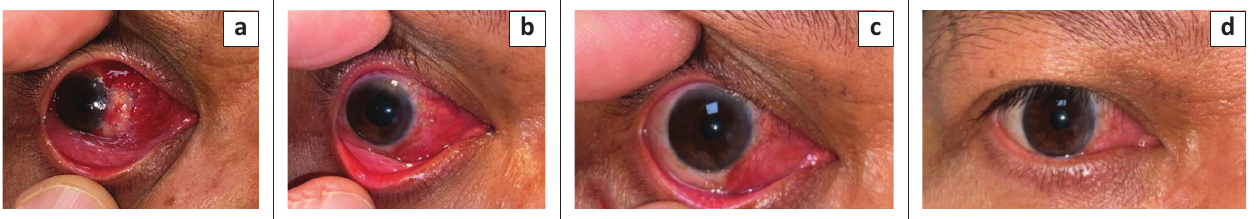
FIGURE 2: Treated pterygium (right eye) showing: (a) one week postoperative with grade 4 conjunctival hyperaemia; (b) and (c) one month postoperative with grade 3 conjunctival hyperaemia; (d) at the end of follow-up with mild (grade 2) nasal conjunctival hyperaemia. a b c